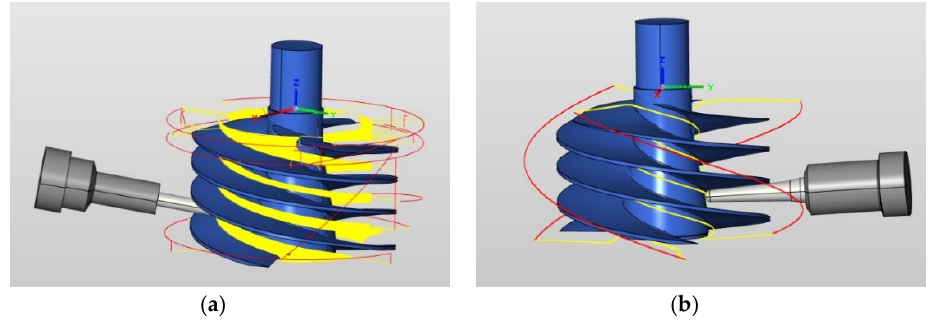
Figure 8. Processing path: ( a ) rough machining; ( b ) semi-finishing and finishing machining.